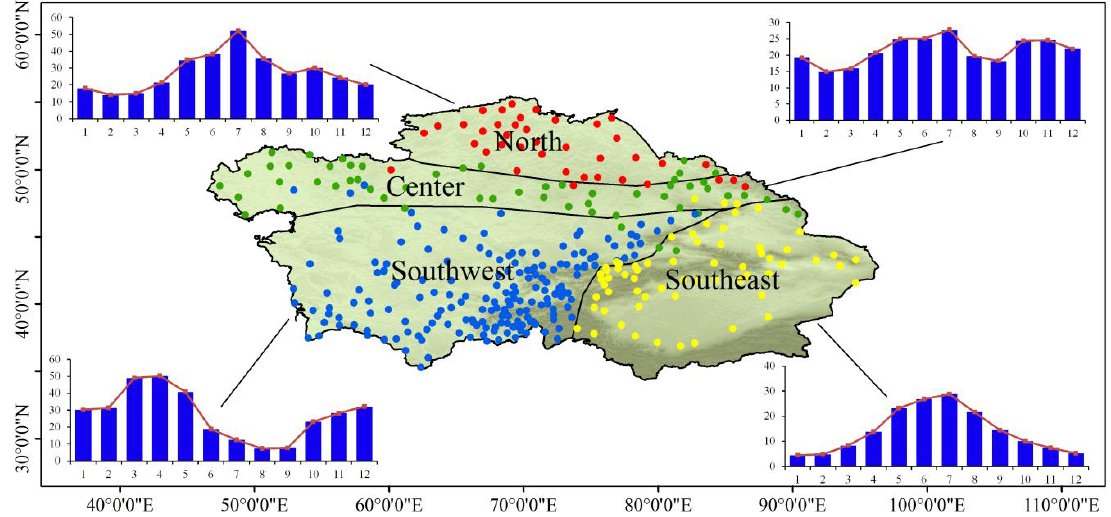
Figure 3. The four subregions (North, Center, Southwest, and Southeast) and the seasonal cycle of precipitation (mm/month).